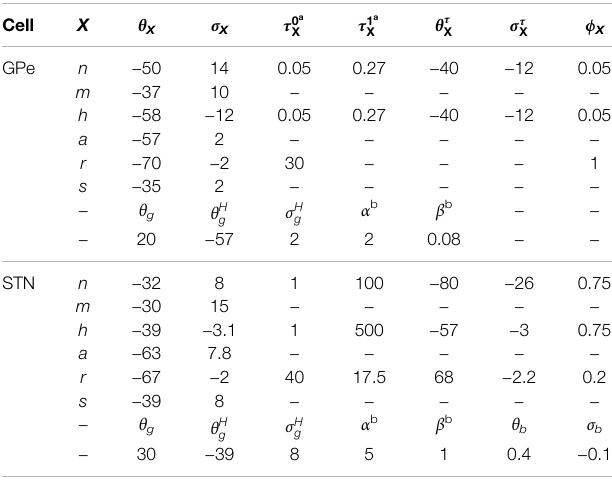
TABLE 2 | Kinetic parameters used for GPe and STN neuron